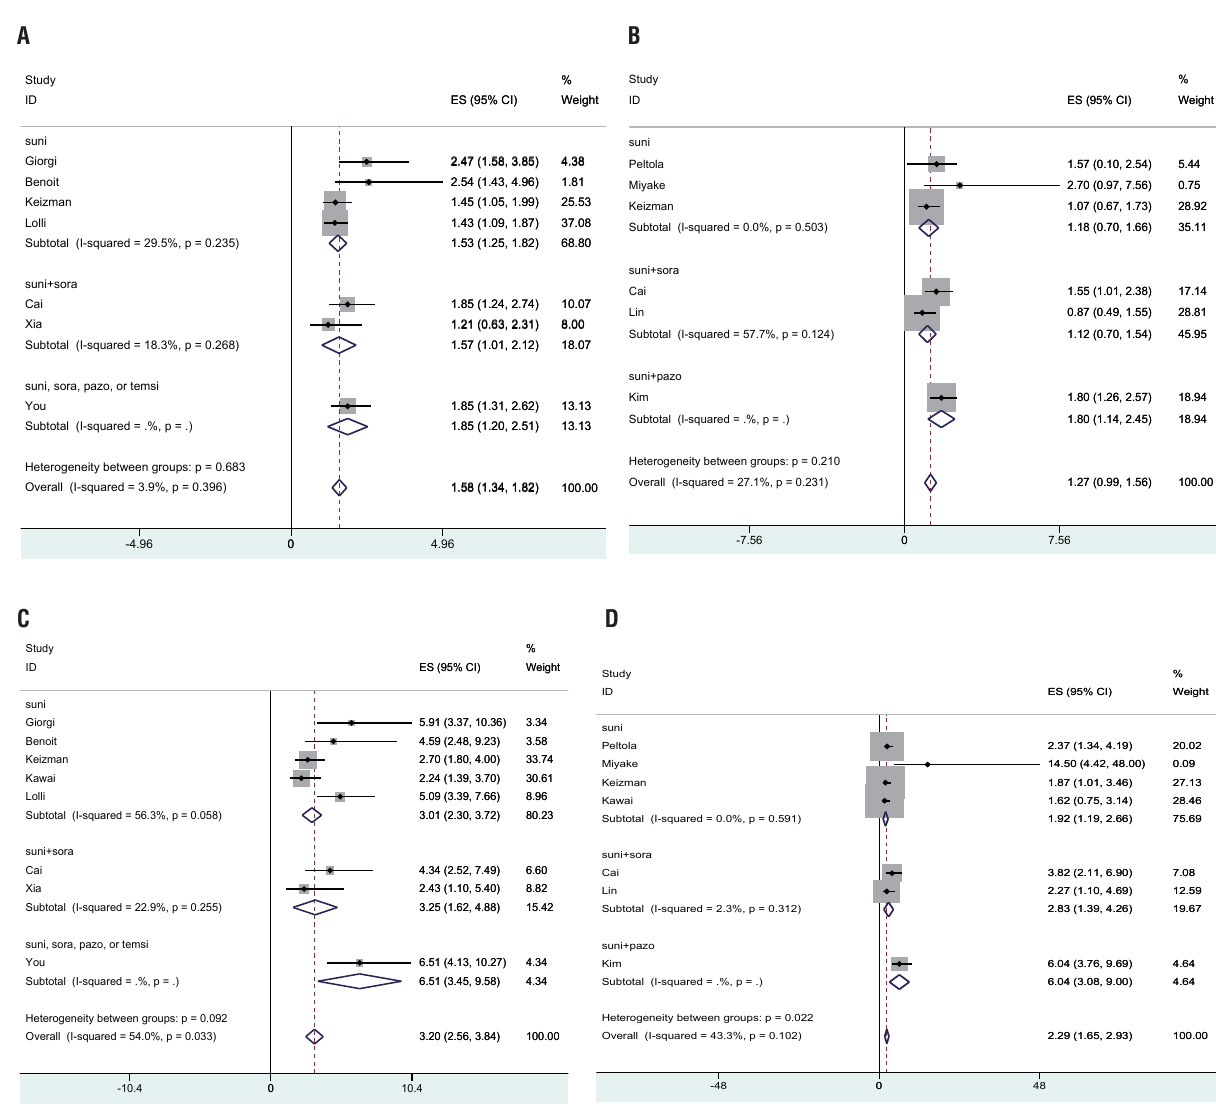
Supplementary Figure 2 - Subgroup analysis of drug type for PFS.